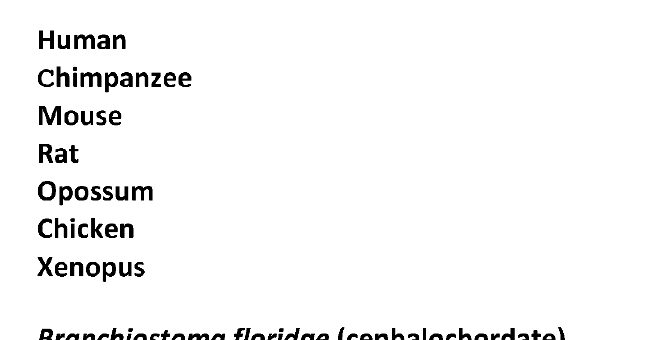
Figure 1. Neuropeptide S (NPS) or NPS-like peptide sequences. Residues divergent from the human NPS sequence are highlighted in red. The C-terminal amide (NH 2 ) in the Branchiostoma peptide is encoded by glycine in the precursor protein and therefore identical to the consensus.